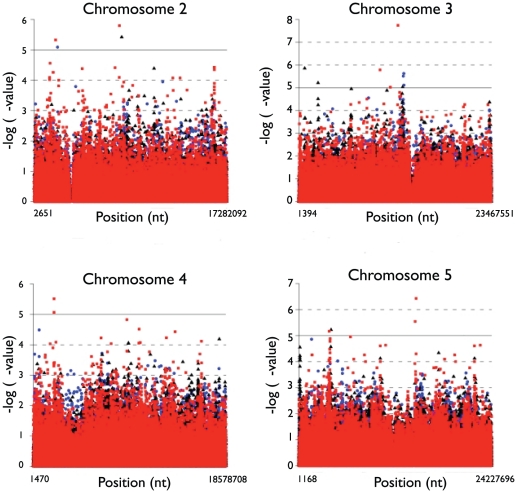
Associations between SNP markers and phenotypes.Peak heights represent negative log p-values from tests of association between genotype and phenotype on chromosomes 2–5. PG, PC and TD50 are plotted in blue circles, black triangles and red squares, respectively. The solid grey line marks a significance level of 0.05%.